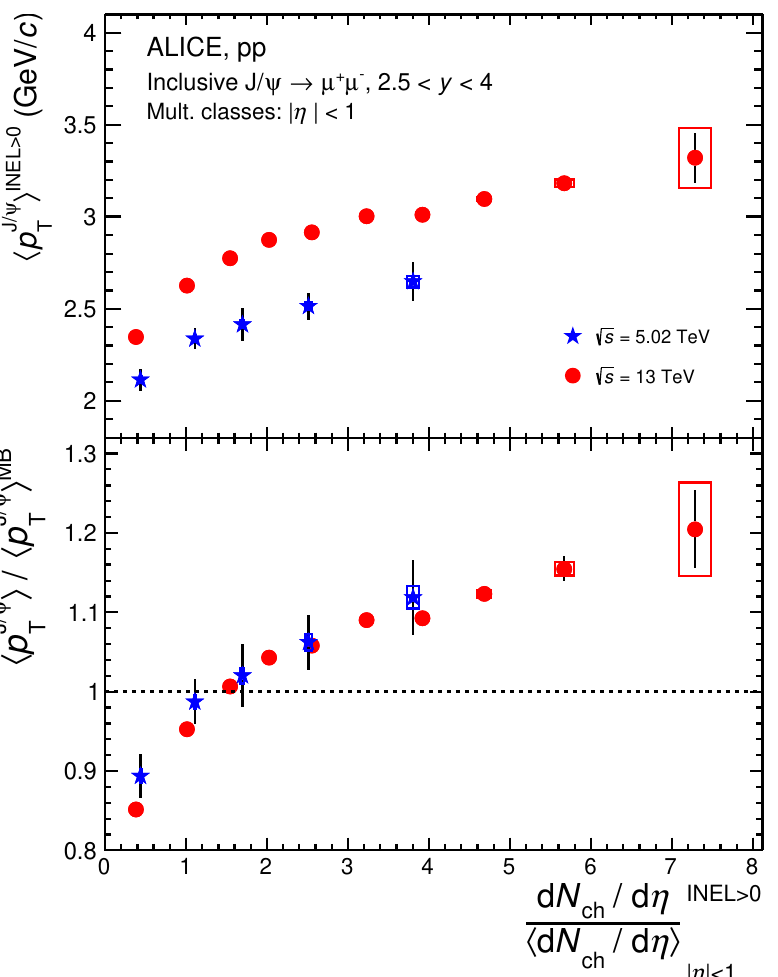
Figure 6 . (Top panel) Forward rapidity mean transverse momentum of J /ψ as a function of the relative charged-particle density in pp collisions at h p J /ψ i shown for the same. The dotted line indicates the deviation of relative h p J /ψ T